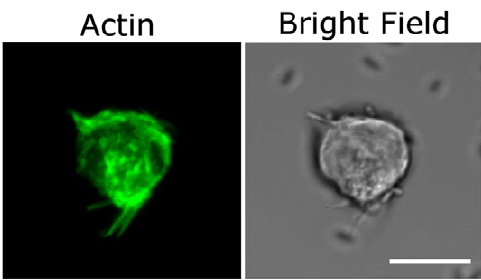
Figure 15. Confocal and DIC images of F-actin staining of a normal neural progenitor cell. Note the presence of F-actin in all filopodial projections as well as in the cytoskeleton of the cell. Scale bars represent 10 m m. (See Movie S9 for 3D reconstruction).